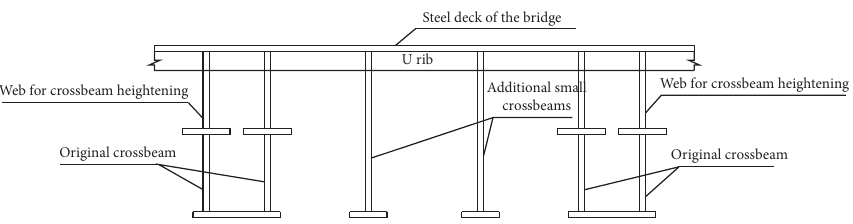
Figure 10: Elevation of the integral steel deck